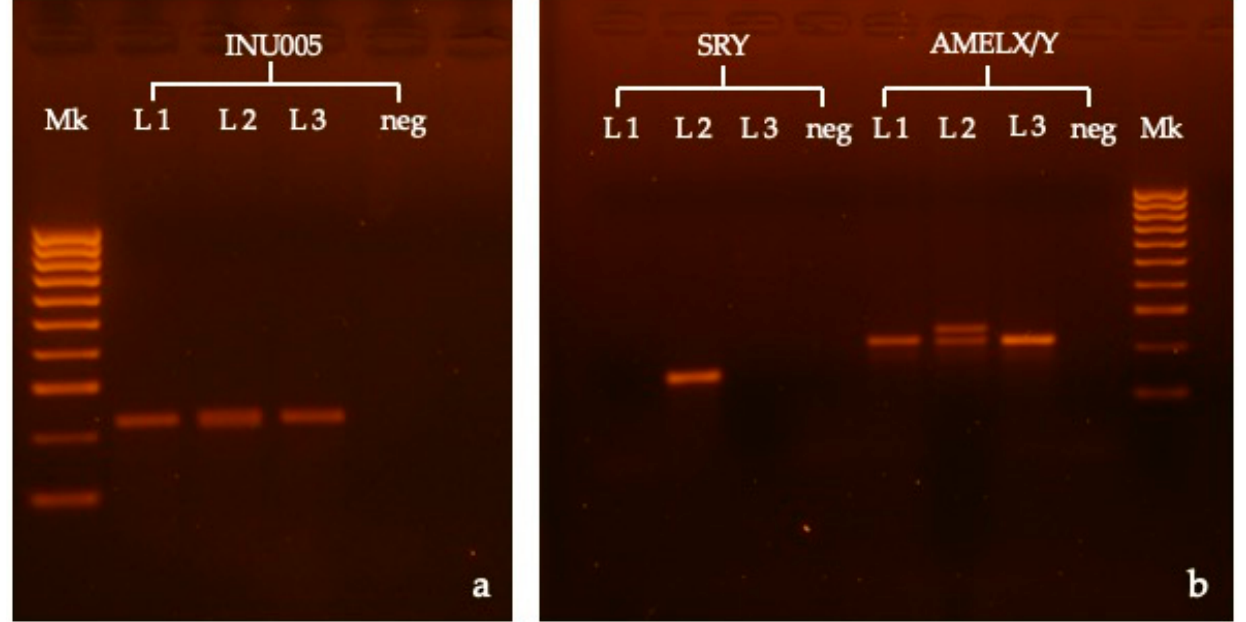
Figure 3. Agarose gel (1.8%) electrophoresis of PCR products of INU005 ( a ), SRY, and AMELX/Y ( b ). Mk = 100 bp molecular marker (HyperLadder 100 bp, BIO-33056, Bioline, London, UK), L1 = case study, L2 = male dog control, L3 = female dog control, neg = negative